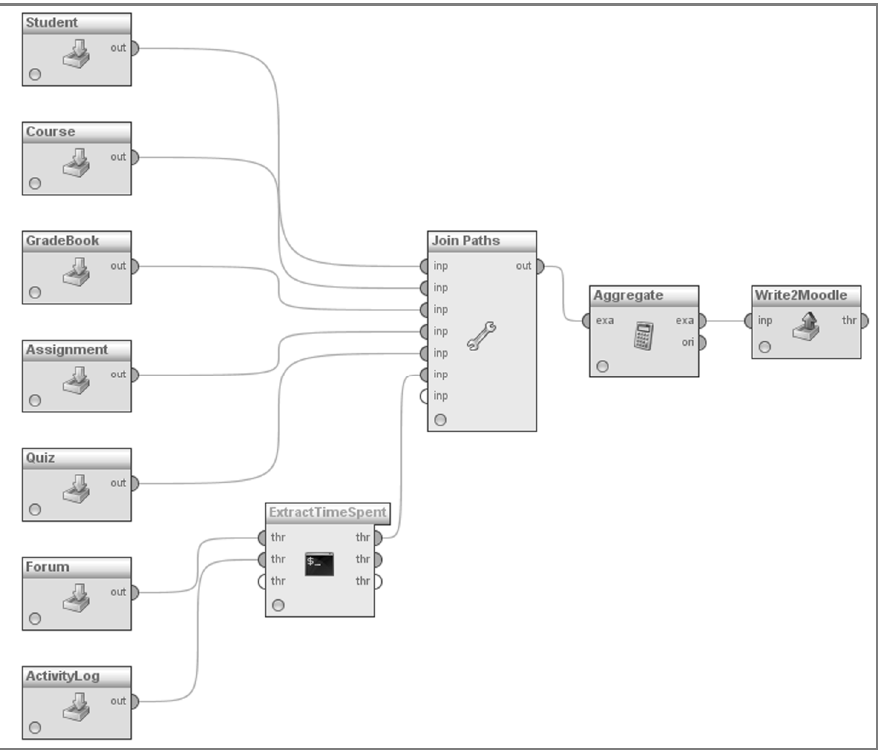
Fig. 1. Automatic data extraction